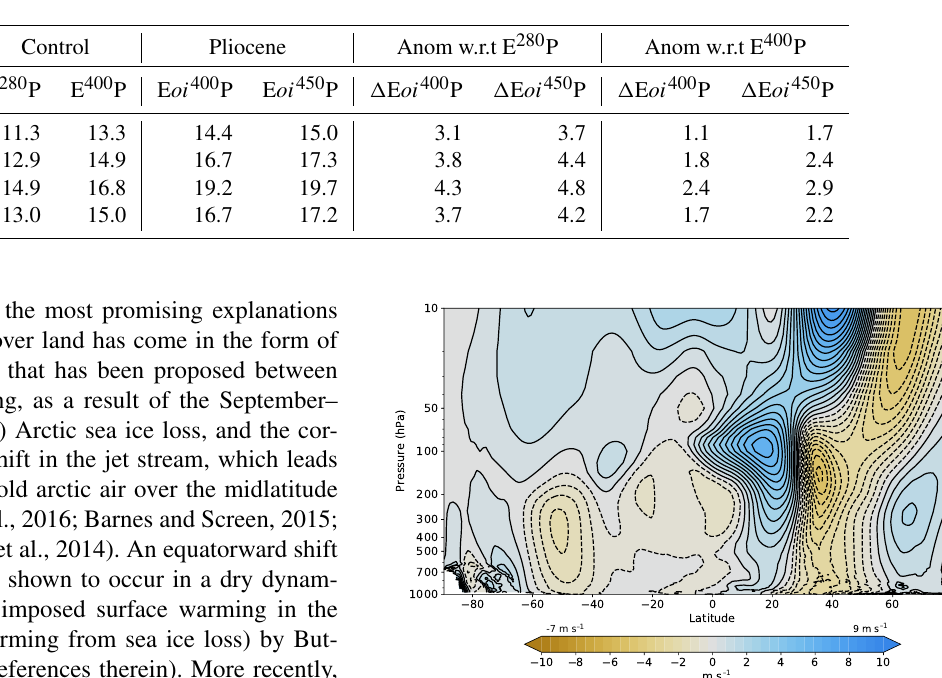
Table 6. Mean seasonal surface air temperatures and anomalies.